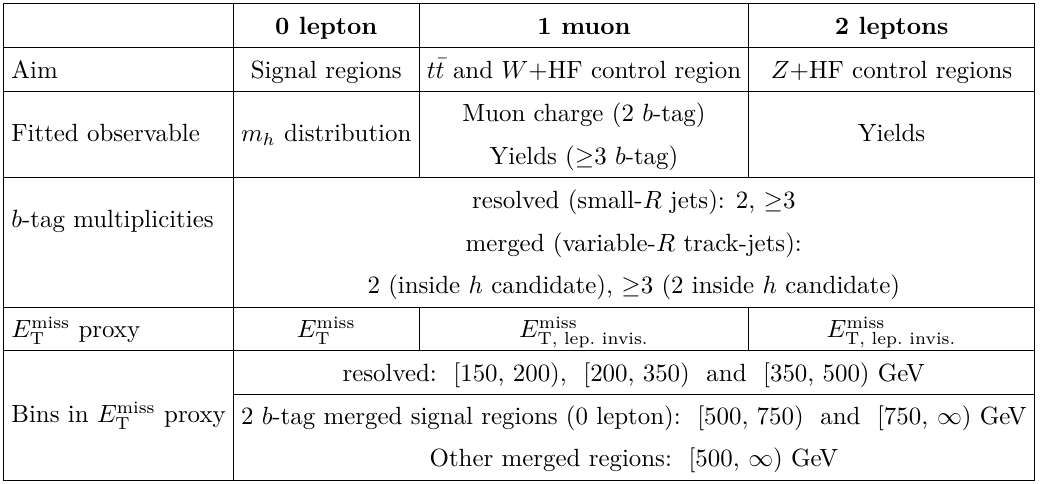
Table 2. Event categories entering the combined fit of the model to the data. The discriminant m h denotes the mass of the light Higgs boson candidate and corresponds either to the dijet mass m jj in the regions selecting two small- R jets or to the large- R jet mass m J for the regions requiring a large- R jet. “Yields” refers to the number of events in a given